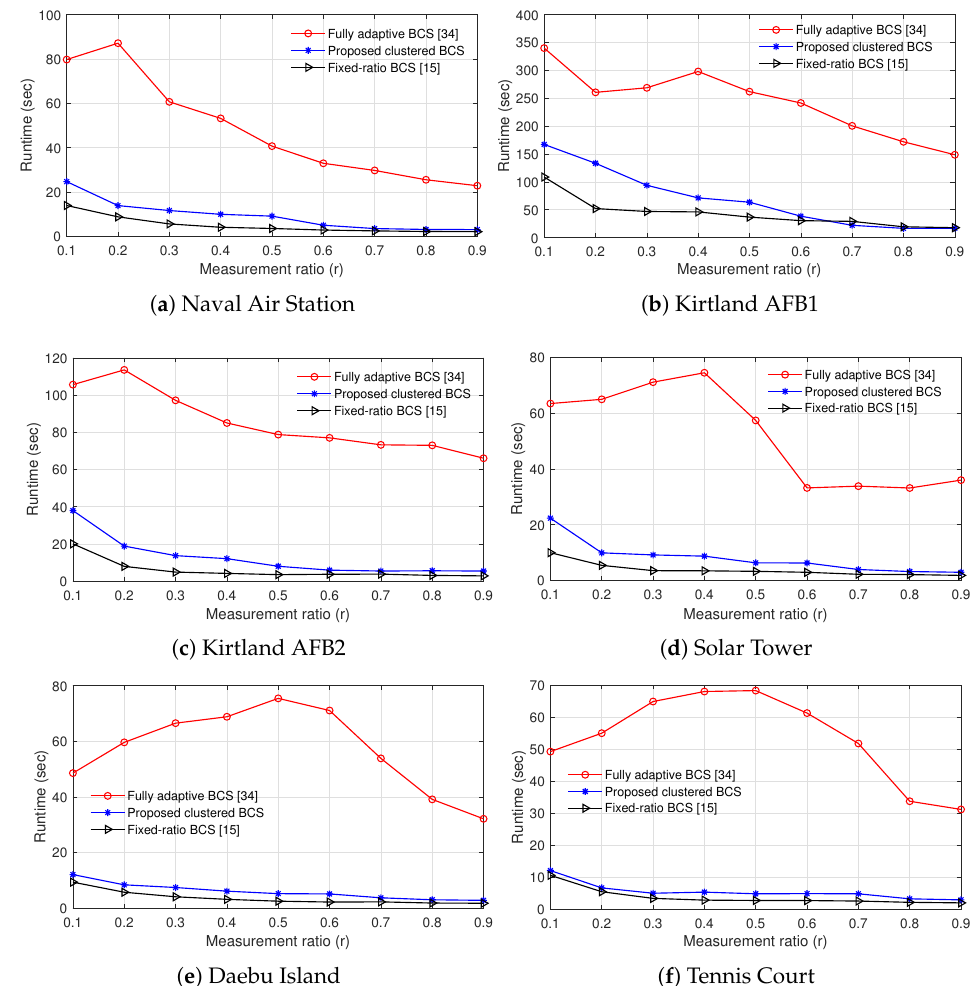
Figure 12. Runtime of various BCS reconstruction methods according to the measurement